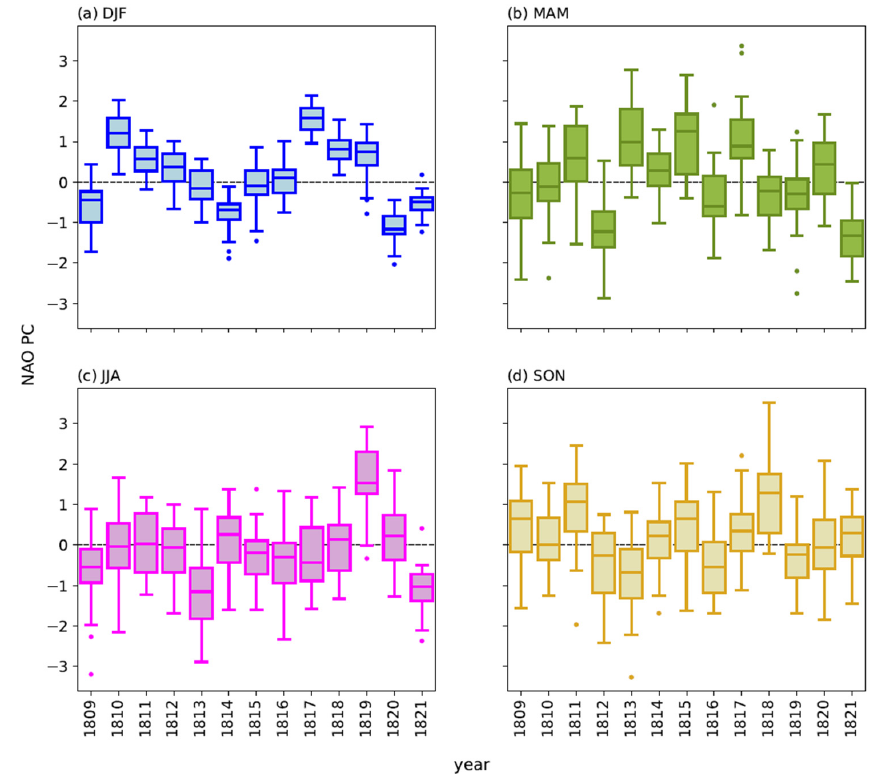
Figure 12. Seasonal series of EKF400v2 ensemble member-based calculations of NAO PC for 1809– 1821 inclusive: ( a ) winter (DJF), ( b ) spring (MAM), ( c ) summer (JJA) and ( d ) autumn (SON). The box and whisker plots show the distribution of ensemble members for each year.